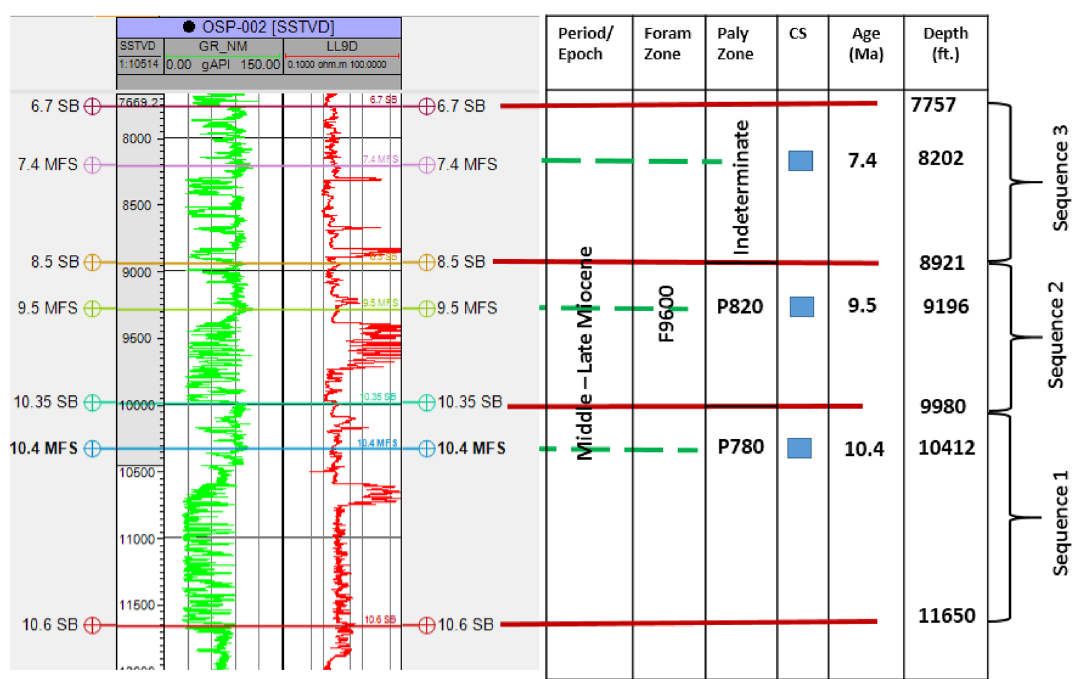
Fig. 9 Key stratigraphic surface identified in OSP